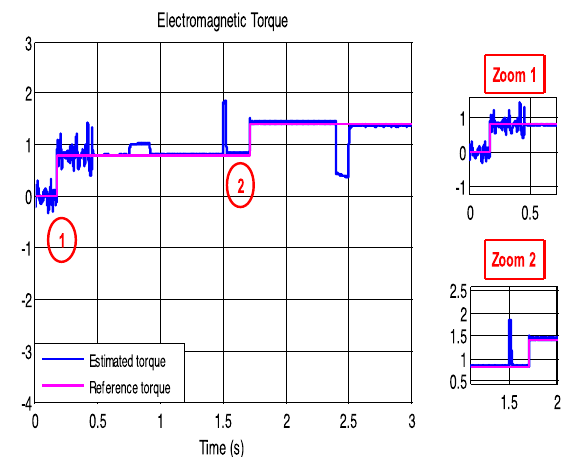
Fig. 23 PI-DTC-SPWM with three-level inverter electromagnetic torque response